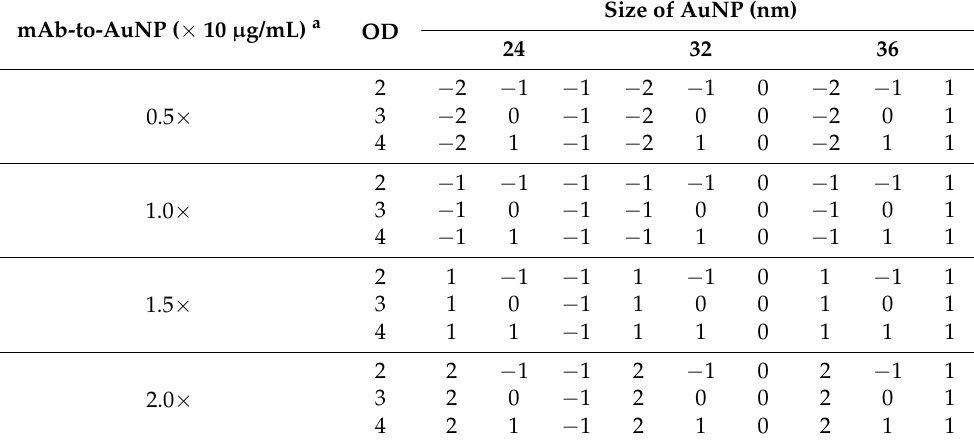
Table 2. The FF-DoE scheme for DE optimization. Each experiment was repeated twice. mAb-to-AuNP ( × 10 µ g/mL)